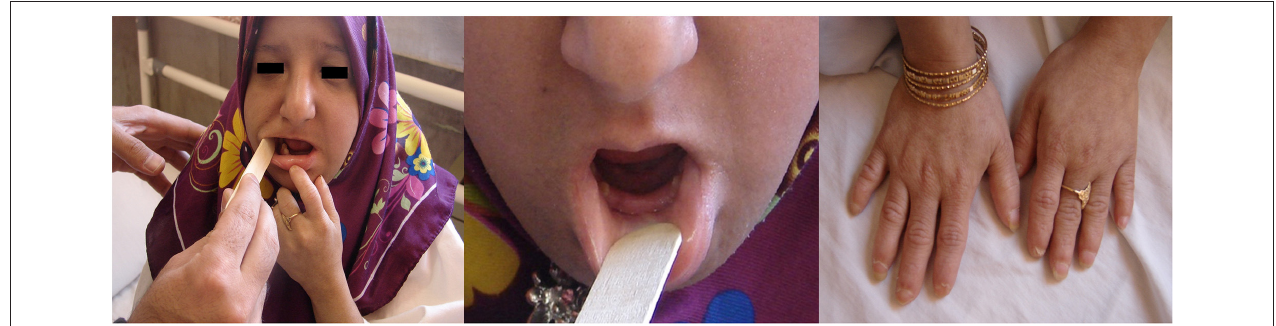
proband and for her extended family, we performed it using the aforementioned kit. Primers F 5 ′ -CAGACTCAGC AGGCTTGTCC-3 ′ and R 5 ′ -CTGCAGCTTCTCCTGGTTCT-3 ′ designed by Primer3.0 (http://bioinfo.ut.ee/primer3-0.4.0) were used. Then, we conducted the polymerase chain reaction (PCR) under the standard conditions. The samples were sequenced using BigDye Terminator v3.1 cycle sequencing kit and 3730 DNA Analyzer (Thermo Fisher), and the obtained results were analyzed using Finch TV and Chromas software ( Figure 3C ). The results confirmed the presence of the homozygote variant (c.7511delA) in the proband and heterozygote one in her parents. In addition, it was perfectly segregated within her extended family ( Figure 3B